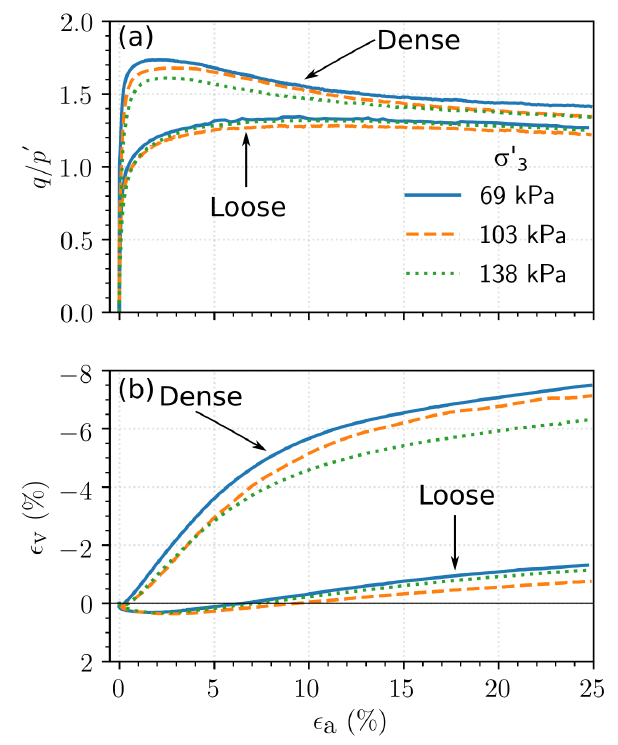
Figure 11. Response of Ottawa sand to drained triaxial compression: ( a ) Stress–strain relationship, ( b ) Volumetric relationship.